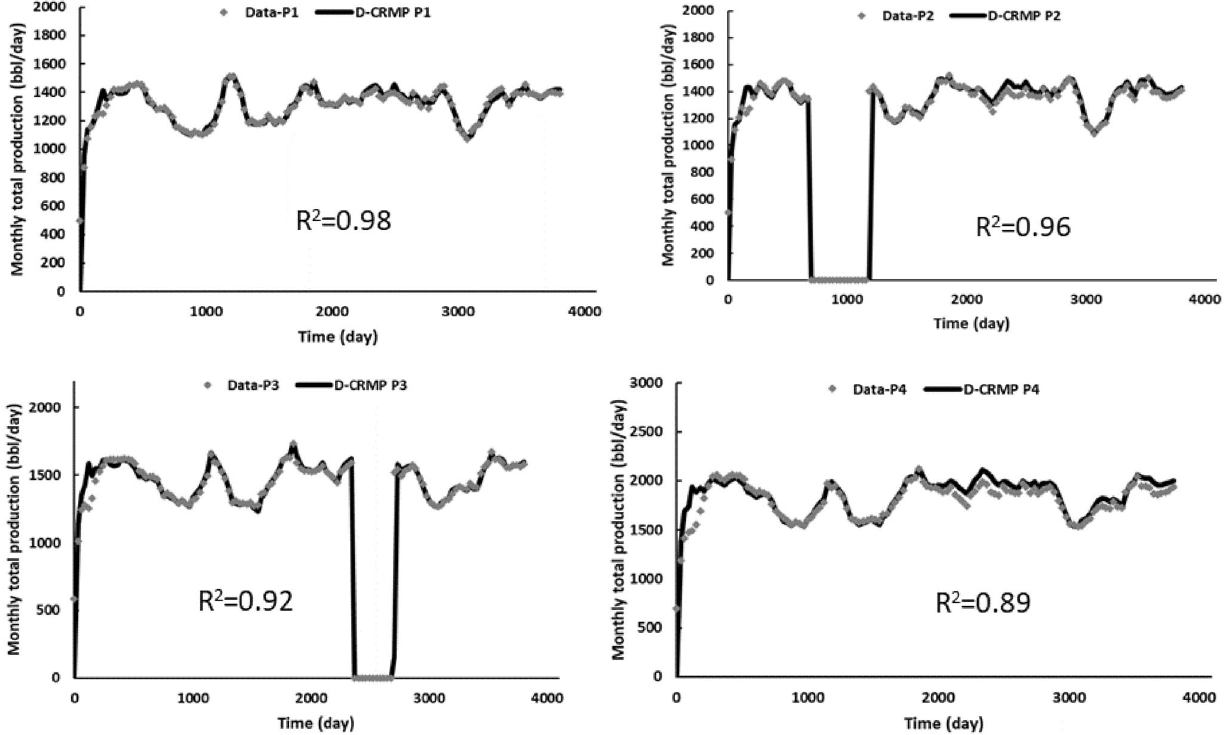
Fig. 19 Liquid production match by D-CRMP for case